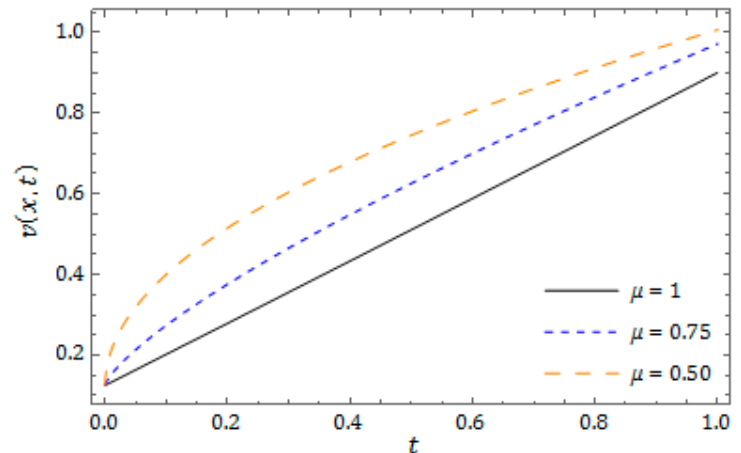
Figure 2 . Nature of the 𝑞 -HATM solution 𝑣(𝑥, 𝑡) in case (𝑖) with respect to 𝑡 at 𝜌 = −0.5,𝜀 = 0.5,ℏ = −1,𝑛 = 1 , and 𝑥 = 1 for diverse 𝜇.